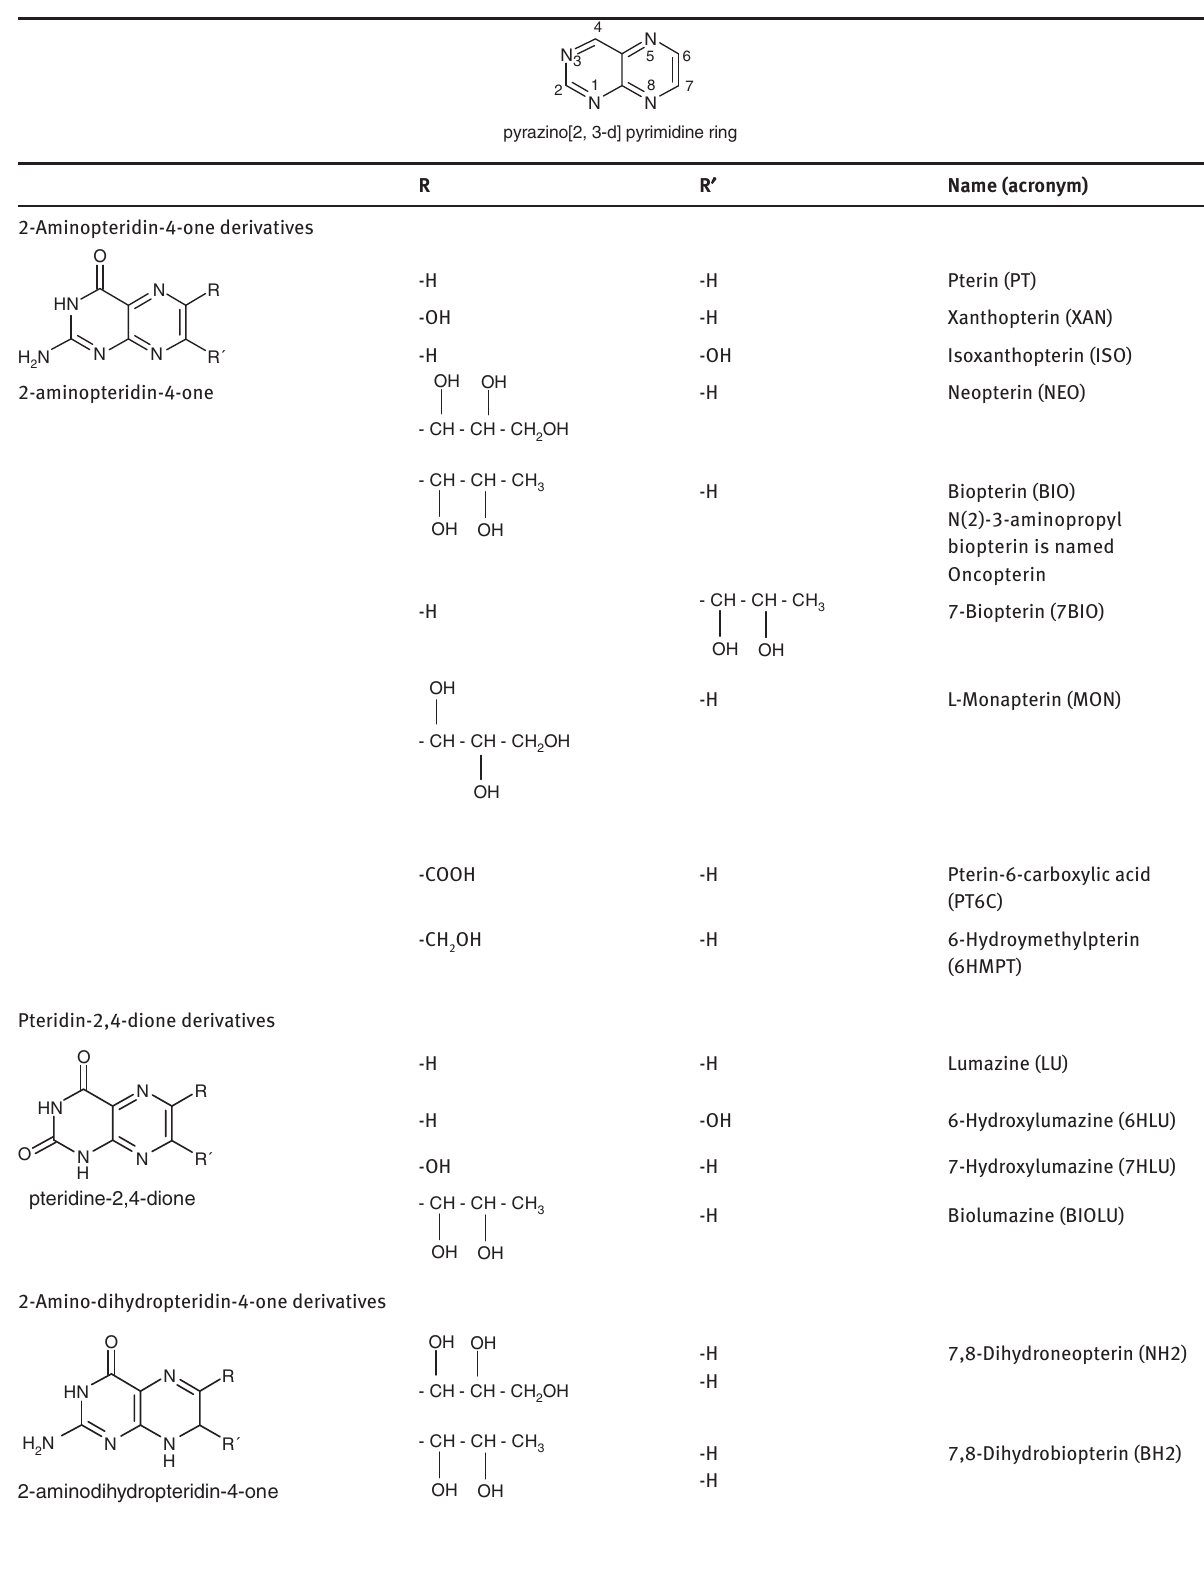
Table 1: Chemical structures of the relevant